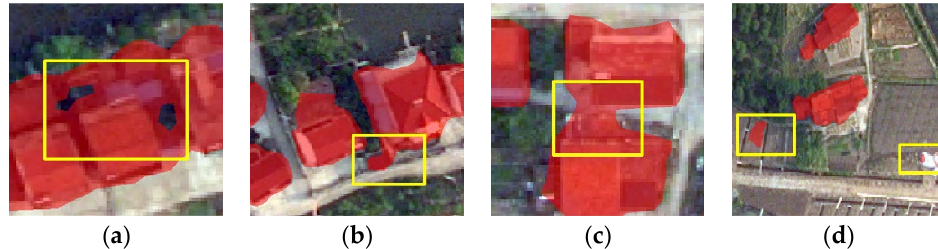
Figure 11. Example of the error patch. ( a ) the hole; ( b ) wrong boundary; ( c ) the connected patch; ( d ) wrong patch.